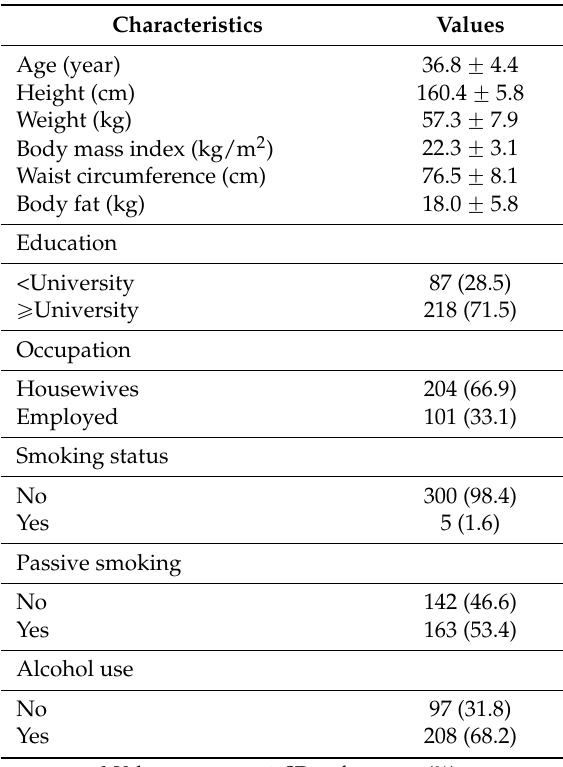
Table 1. Study population general characteristics a ( n =